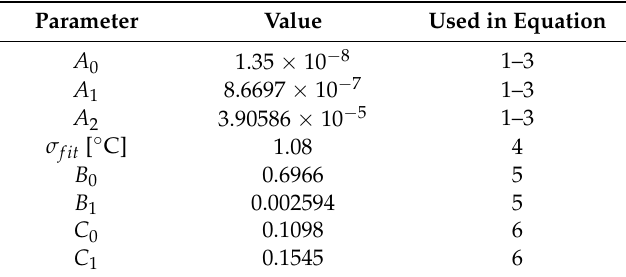
Table A1. Table of calibration and uncertainty fit parameters for 1 ms shutter speed.